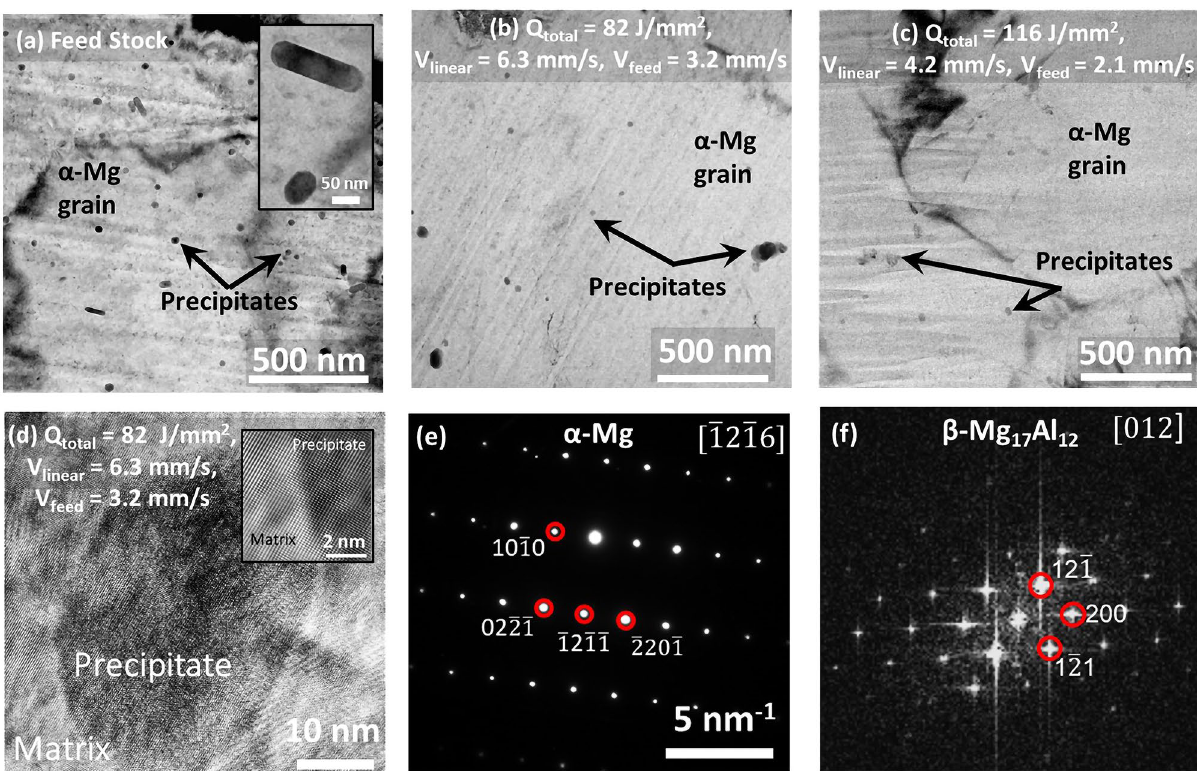
Figure 4. TEM data showing bright field images for ( a ) feed stock with inset showing magnified view of 2 2 the precipitates, ( b ) 82 J/mm AFSD sample, ( c ) 116 J/mm AFSD sample, and ( d ) high resolution view of 2 precipitate in 82 J/mm AFSD sample with inset showing the coherent interface between precipitate and the matrix. The selected area diffraction pattern in ( e ) corresponds to α -Mg matrix and ( f ) is the fast Fourier transform image depicting β Mg 17 Al 12